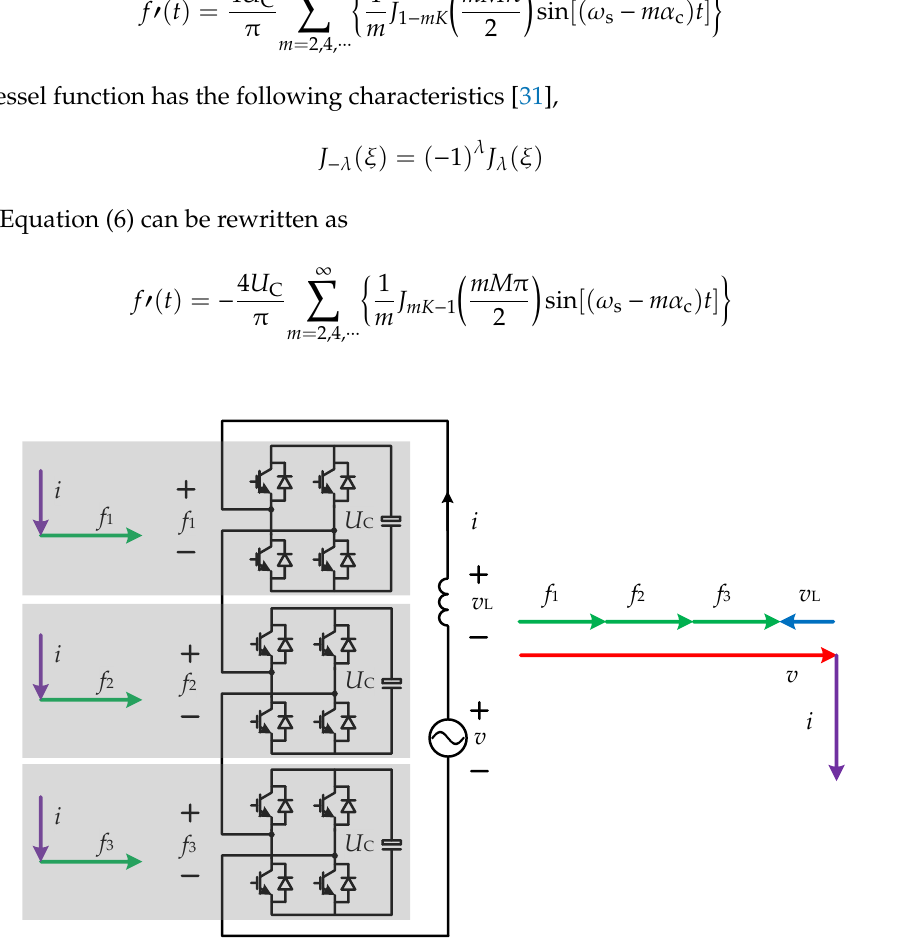
Figure 4. Vector graphs for CHB-STATCOM in an ideal